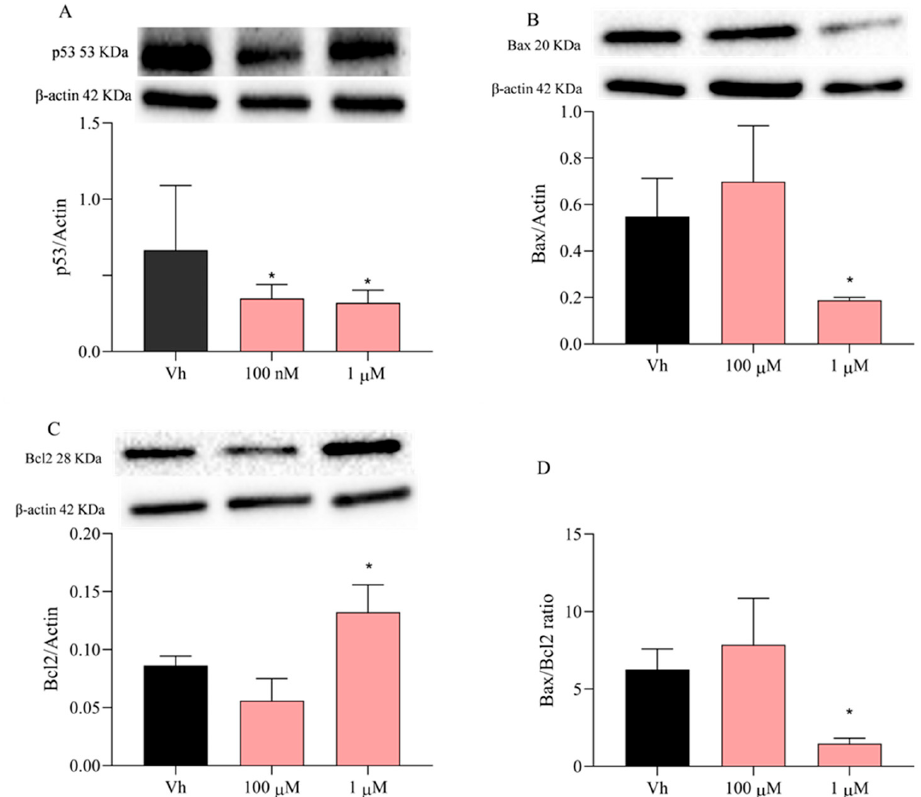
Figure 7. Levels of p53, Bax, and Bcl2 in differentiated SH-SY5Y cells after the treatment with VNZ. Cells were differentiated with retinoic acid and then treated for 48 h with VNZ 100 nM or 1 µ M. The levels of p53 ( A ), Bax ( B ) and Bcl2 ( C ) were evaluated by Western Blotting. The ratio between Bax and Bcl2 is represented in panel ( D ). Data are expressed as the ratio between the protein of interest and β -actin expression and reported as mean ± SD of three independent experiments (( A ): * p < 0.05 vs. VH; ( B ): * p < 0.05 vs. VH; ( C ): * p < 0.05 vs. VH; ( D ): * p < 0.05 vs. VH. One-way ANOVA, post hoc test Dunnett).